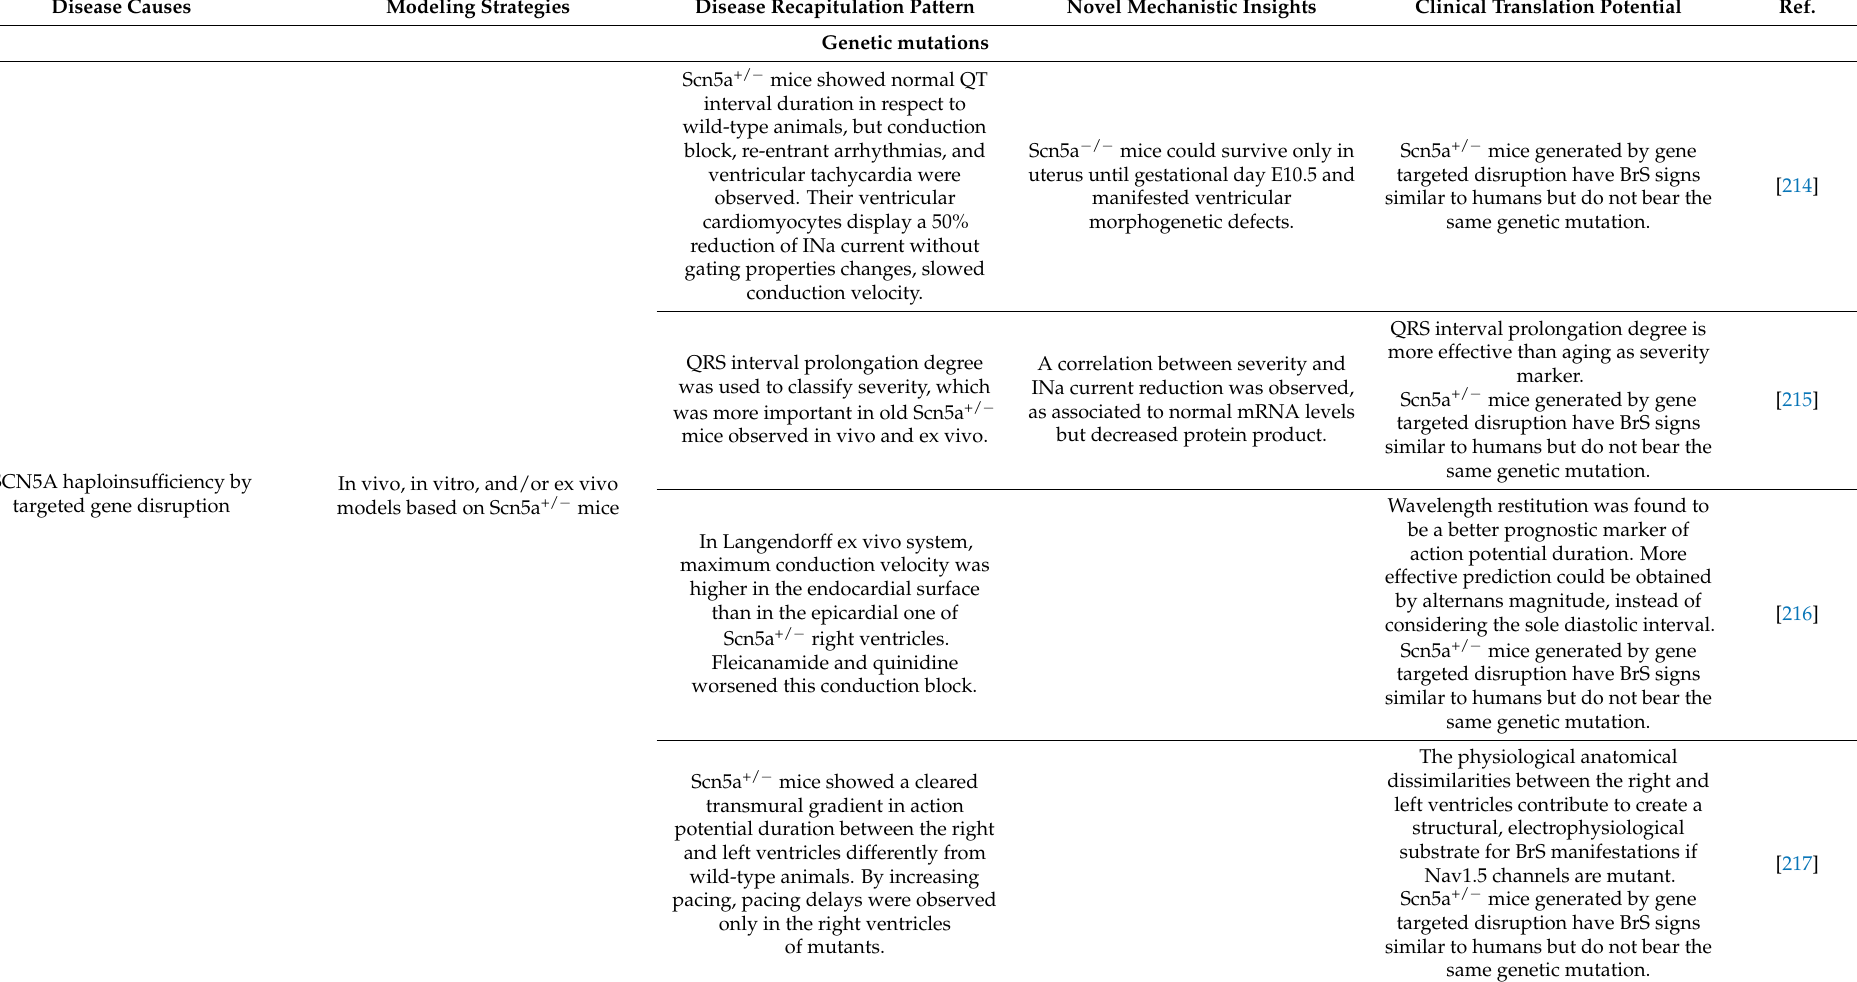
Table 2. Brugada syndrome (BrS): causes, modeling strategies, and their clinical